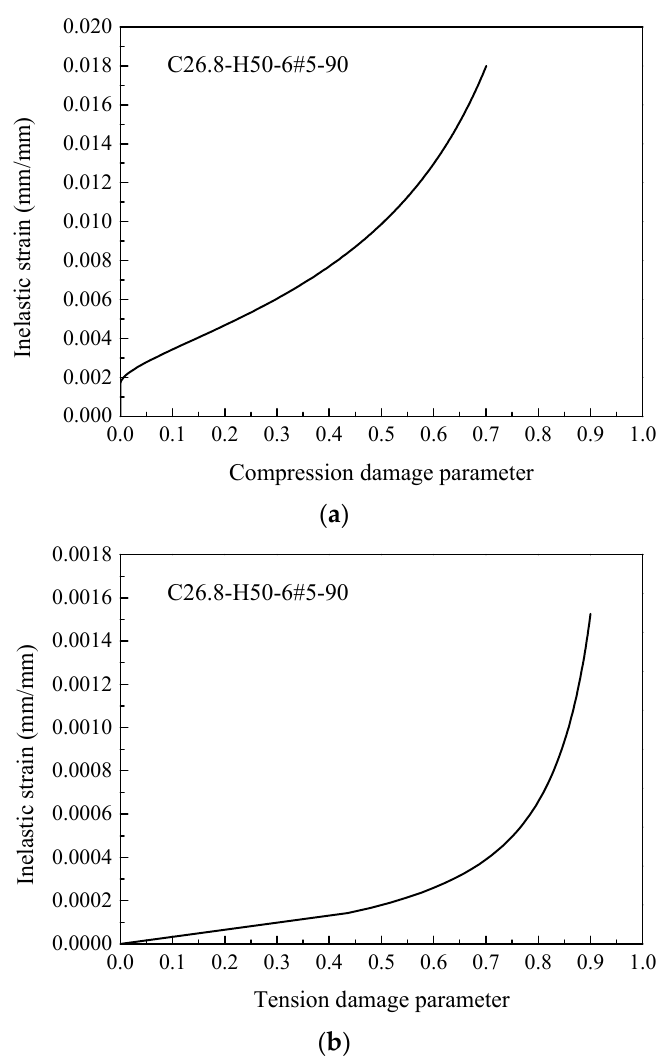
Figure 4. Relationship between the damage parameter and the inelastic strain of concrete for specimen C26.8-H50-6#5-90: ( a ) Represents the compression behavior; ( b ) Represents the tension behavior.